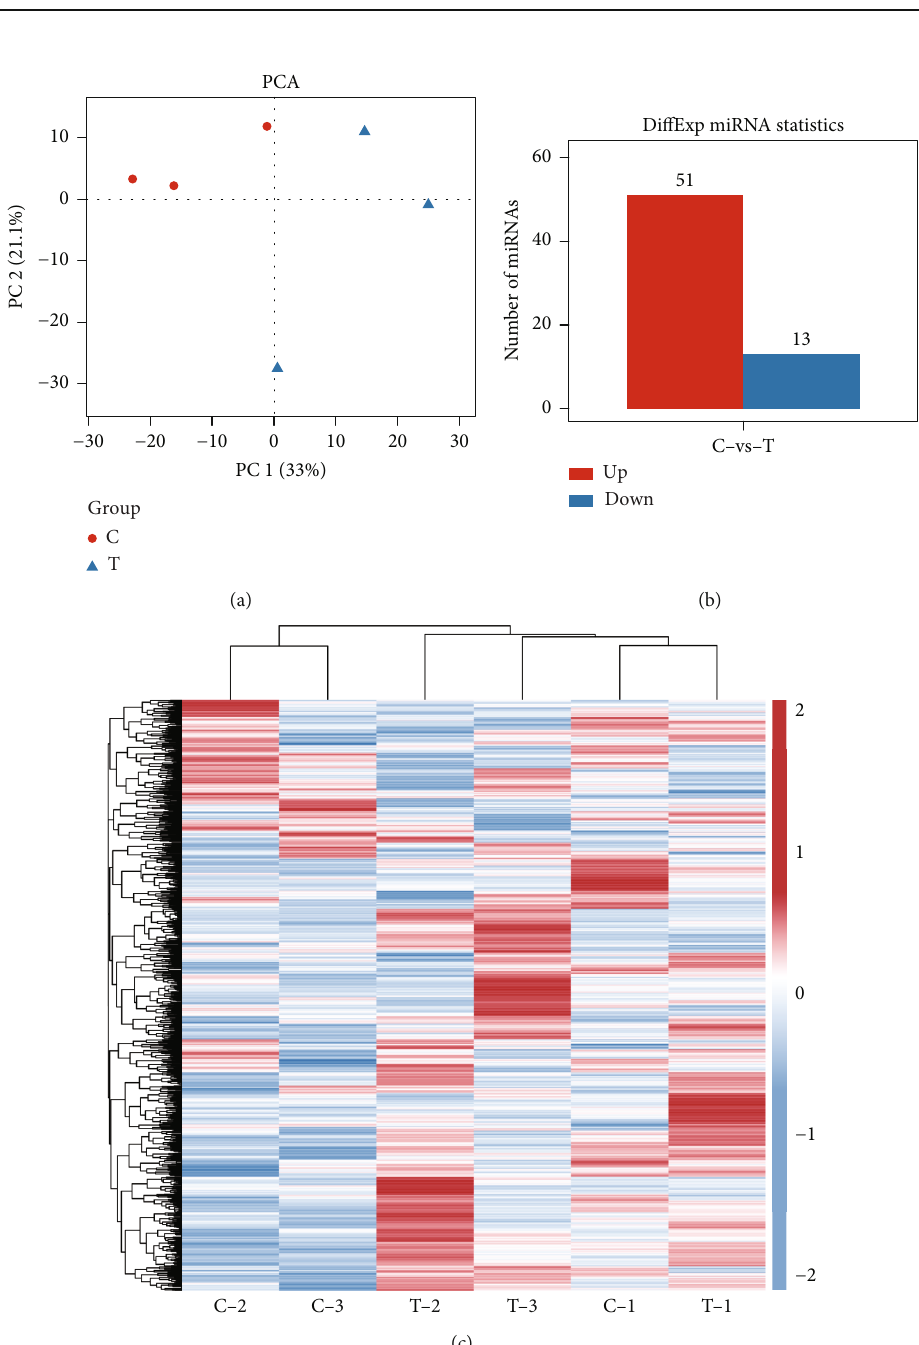
Figure 1: miRNA expression pro fi les in tree shrew periodontal tissues. (a) PCA of miRNA in samples. (b) Heatmaps of strati fi ed cluster analysis of di ff erentially expressed miRNAs in the control (C-1, C-2, and C-3) and treatment (T-1, T-2, and T-3) groups. (c) The statistics of upregulated and downregulated miRNAs in the control and treatment